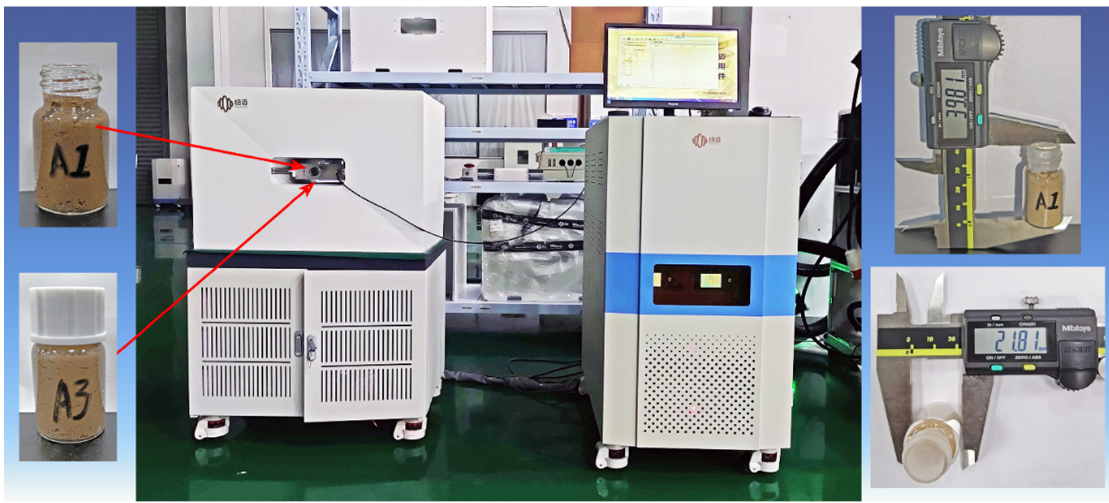
Figure 5. Nuclear magnetic resonance analysis instrument and test samples.